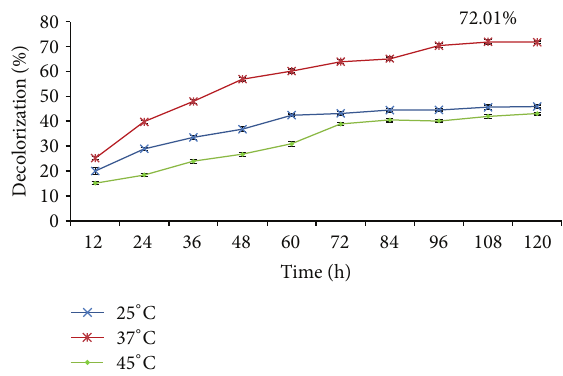
Figure 2: Effect of temperature on decolorization